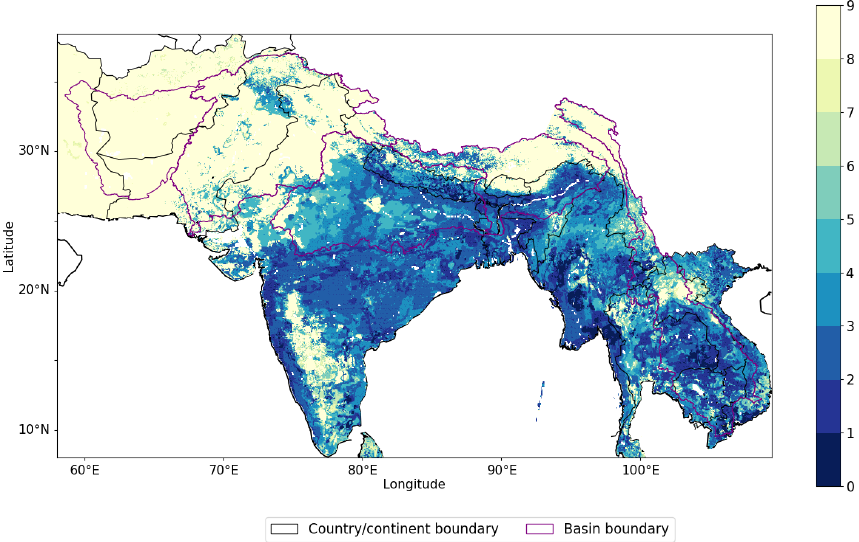
Figure 8. The smallest lead month when the forecast skills of root zone soil moisture (1m) between hindcast simulations using real initial condition and climatological initial condition (CIC) against retrospective simulations is less than